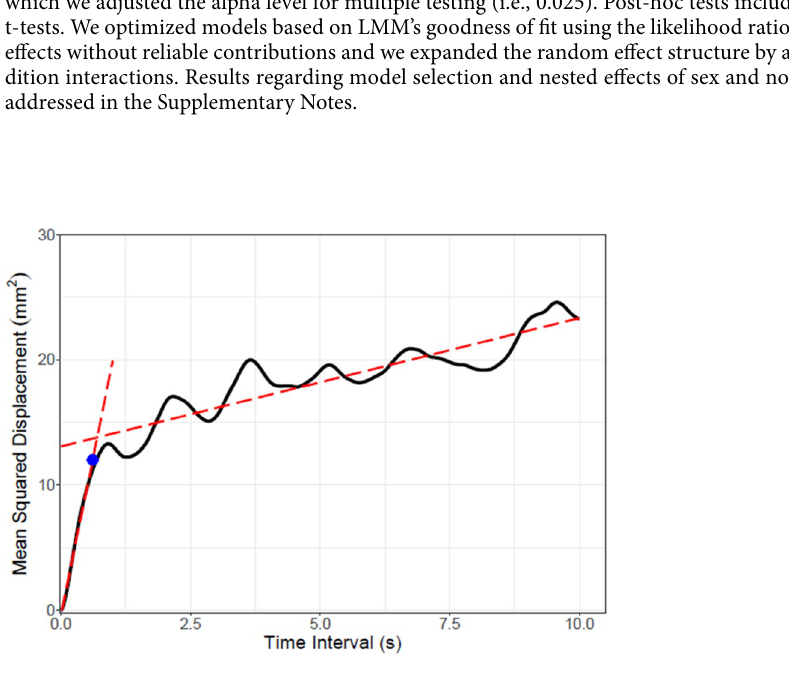
Figure 5. Graphical example of stabilogram diffusion plot in a representative subject in stable stance. Red dotted lines represent the slopes of the short and long timescale regions. The critical point is depicted in blue and represents the separation between short and long timescale